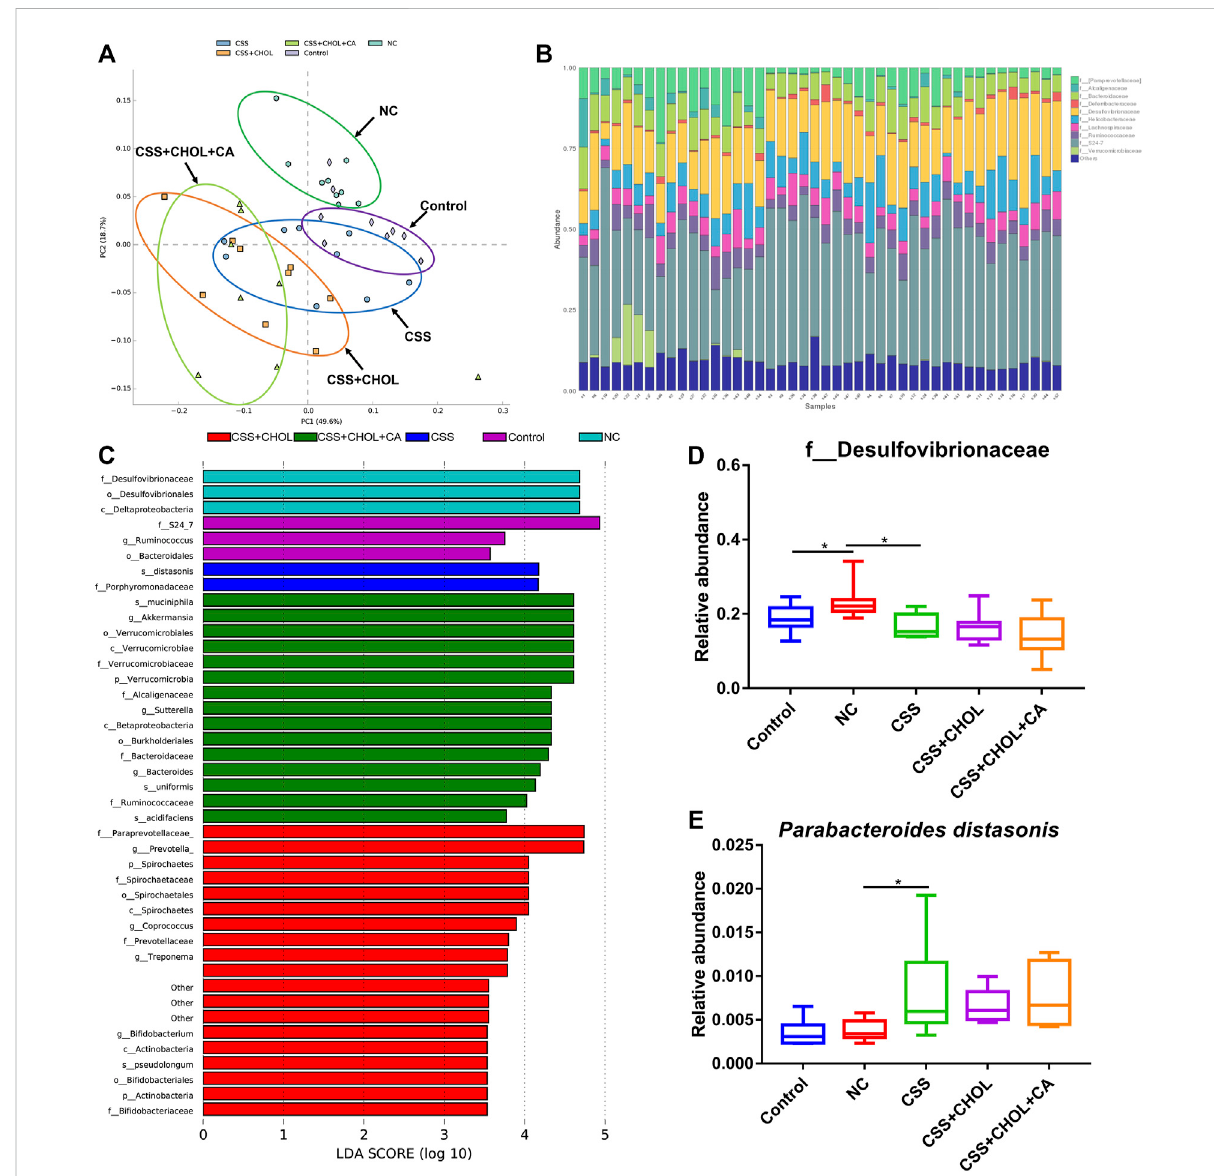
FIGURE 4 CSSrestoresthenormalintestinalmicro fl oraconstitutioninmiceexposedtoCUMS.16SrRNAsequencingwasperformedusingcoloncontents of control mice as well as mice exposed to CUMS and treated with saline (NC), CSS, or CSS with the BA chelator CHOL (with or without CA). (A) PCA plot comparing groups based on abundance of bacterial families within the colon. (B) Relative amounts of bacterial families within the colon from each group. (C) LDA analysis comparing intestinal micro fl ora between groups. (D,E) Relative abundance of (D) f_Desulfovibrionaceae and (E) Parabacteroides distasonis in colons collected from different groups. Values in (D,E) are expressed as means ± S.D. An asterisk “ * ” denotes p < 0.05 ( n = 8-9 mice per